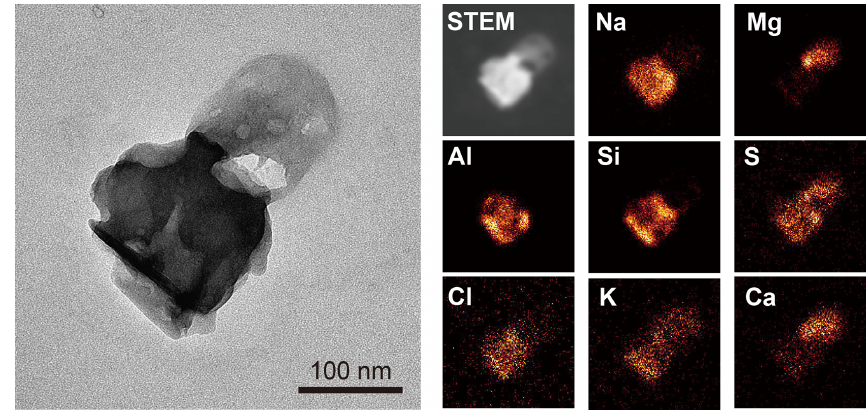
Figure 2. TEM (left) and elemental mapping images (right) of a mineral dust particle mixed with sea salt. This particle was obtained from a cloud residual sample collected on 12 November 2018 (07:30UTC).